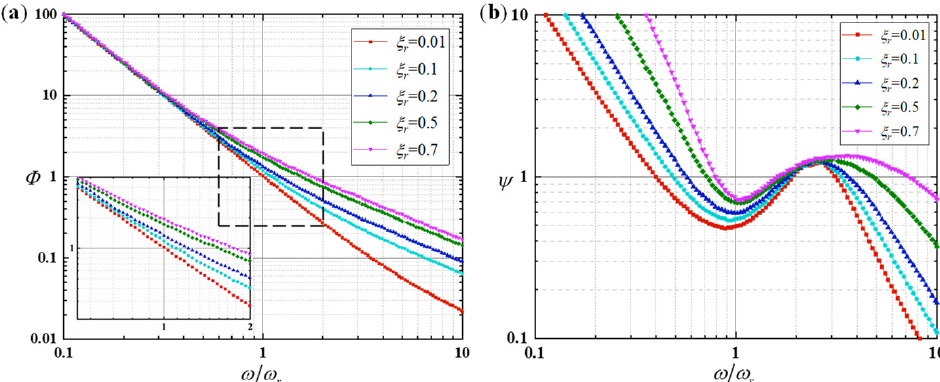
Figure 2. Dynamic characteristics of the hybrid vibration isolation system: ( a ) The estimated demand of actuator force; ( b ) the amplitude admittance ratio.